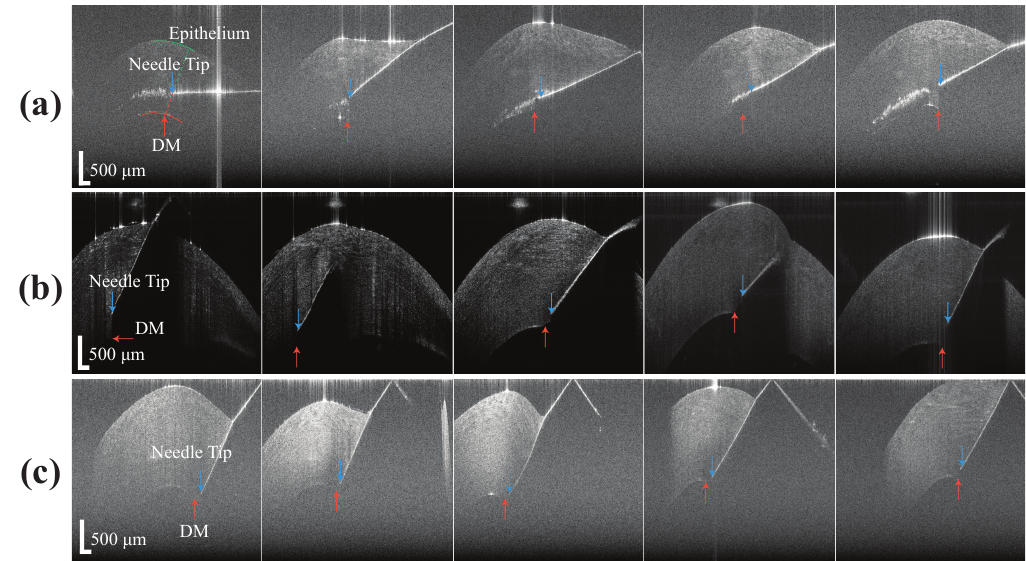
Figure 6. The B-scan of the porcine cornea with needle tip inside, ( a ) results from freehand test, ( b ) results from assisted freehand test, ( c ) results from the AUTO-DALK